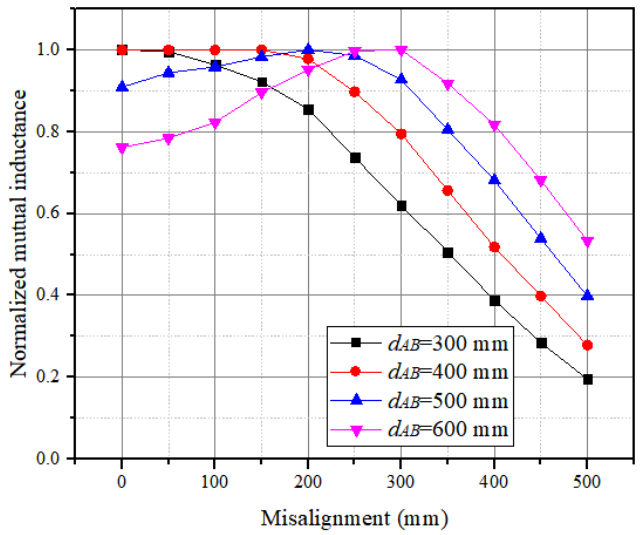
Figure 7. The normalized mutual inductance in misalignment with different d AB values.